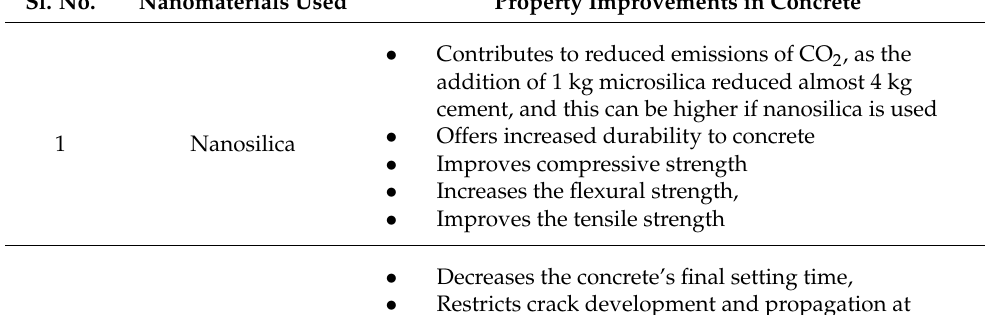
Table 3. Overview of the improvements in concrete properties with the addition of nanomaterials. Sl.